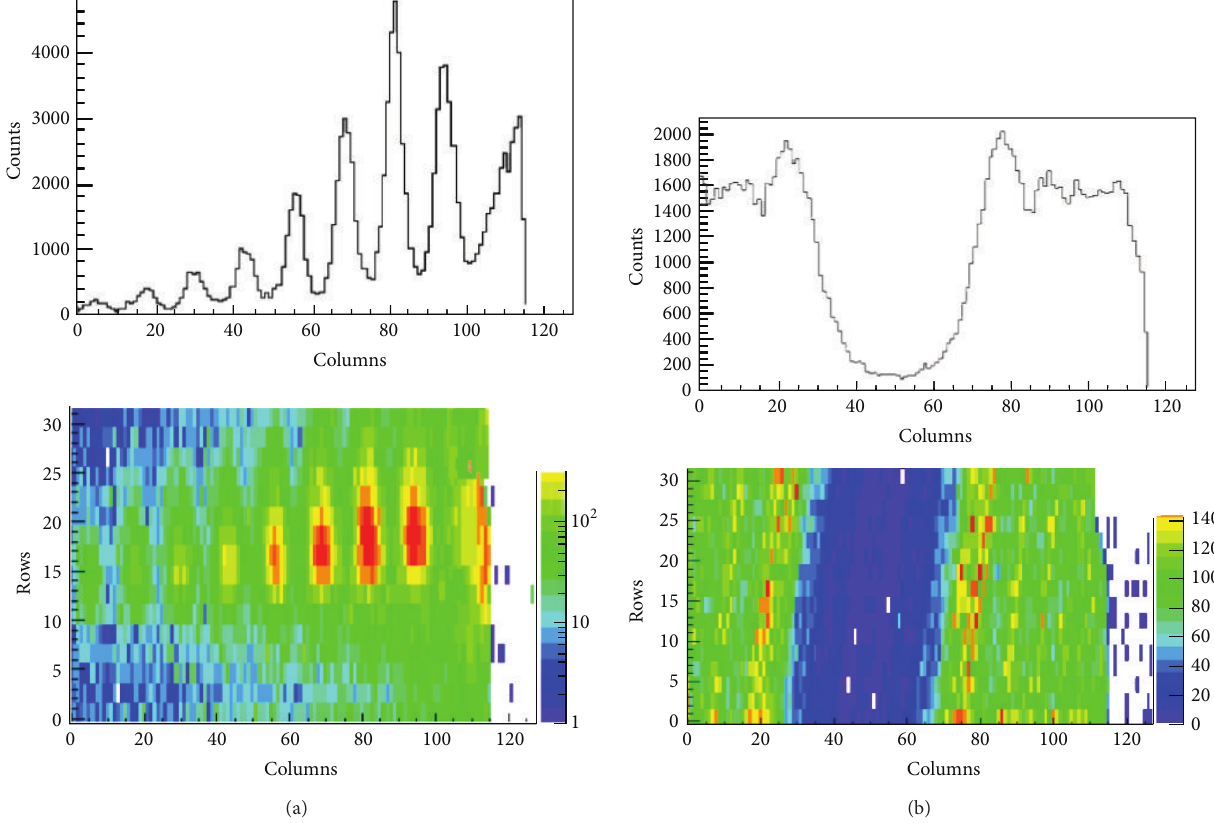
Figure 32: (a) Carbon grating image. Fringes on top. (b) Wire image. Fringes on